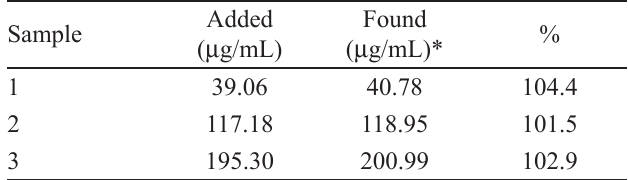
TABLE II - Recovery of fluconazole in a standard addition experiment for accuracy evaluation